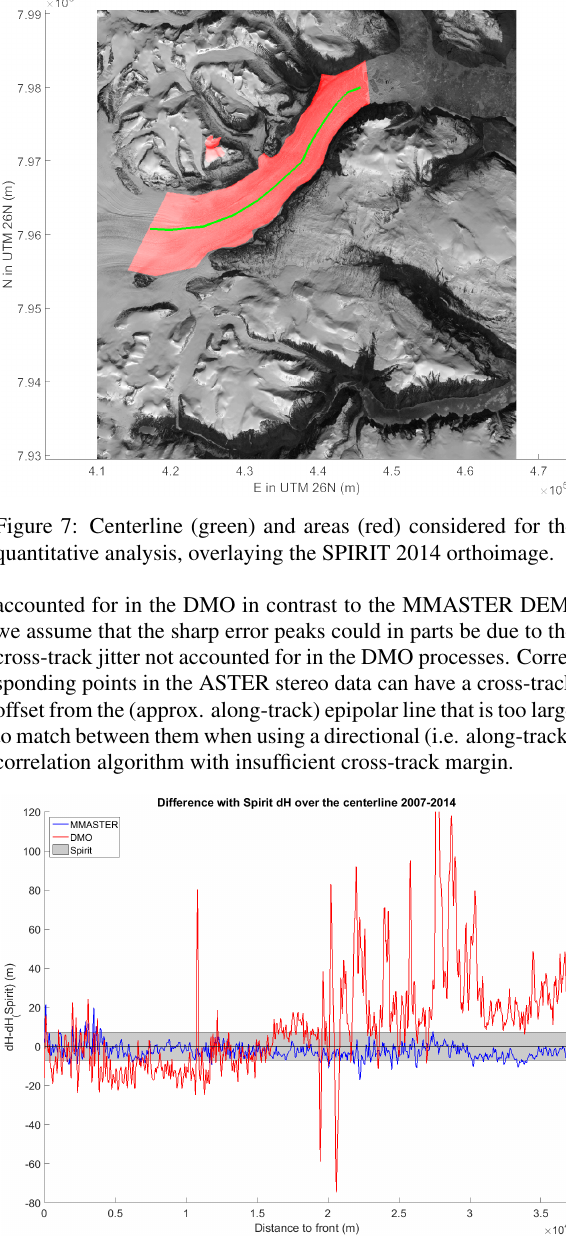
Figure 8: Difference along the centerline (shown in Figure 7) be- tween the 2007-2014 elevation change from the SPIRIT data (set as reference data and thus zero; error bar shown in grey; see Fig- ure 9) and the elevation change from our product (MMASTER, see Figure 6) and the DMO product (see Figure